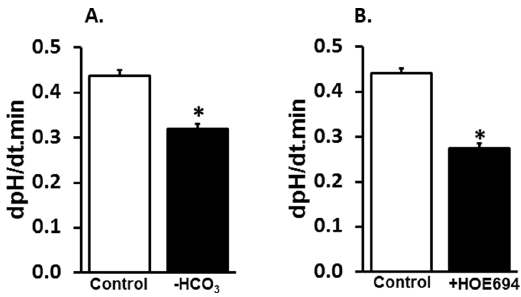
Figure 11. Effect of extracellular HCO 3 and HOE694 on the rate of intracellular pH (pHi; proton extrusion) in crypt glands from proximal colon. [ A ] Rate of change in pHi was examined in presence ( Control ) and absence ( -HCO 3 ) of extracellular HCO 3 . [ B ] Rate of change in pHi in the presence of extracellular HCO 3 was examined in presence ( HOE694 ) and absence ( Control ) of 1 m M HOE694. * p , 0.001 - compared to respective control.